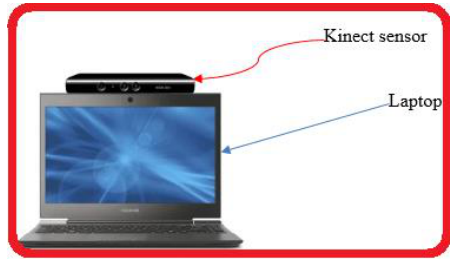
Figure 30. Acquisition environment for the Kinect face database.